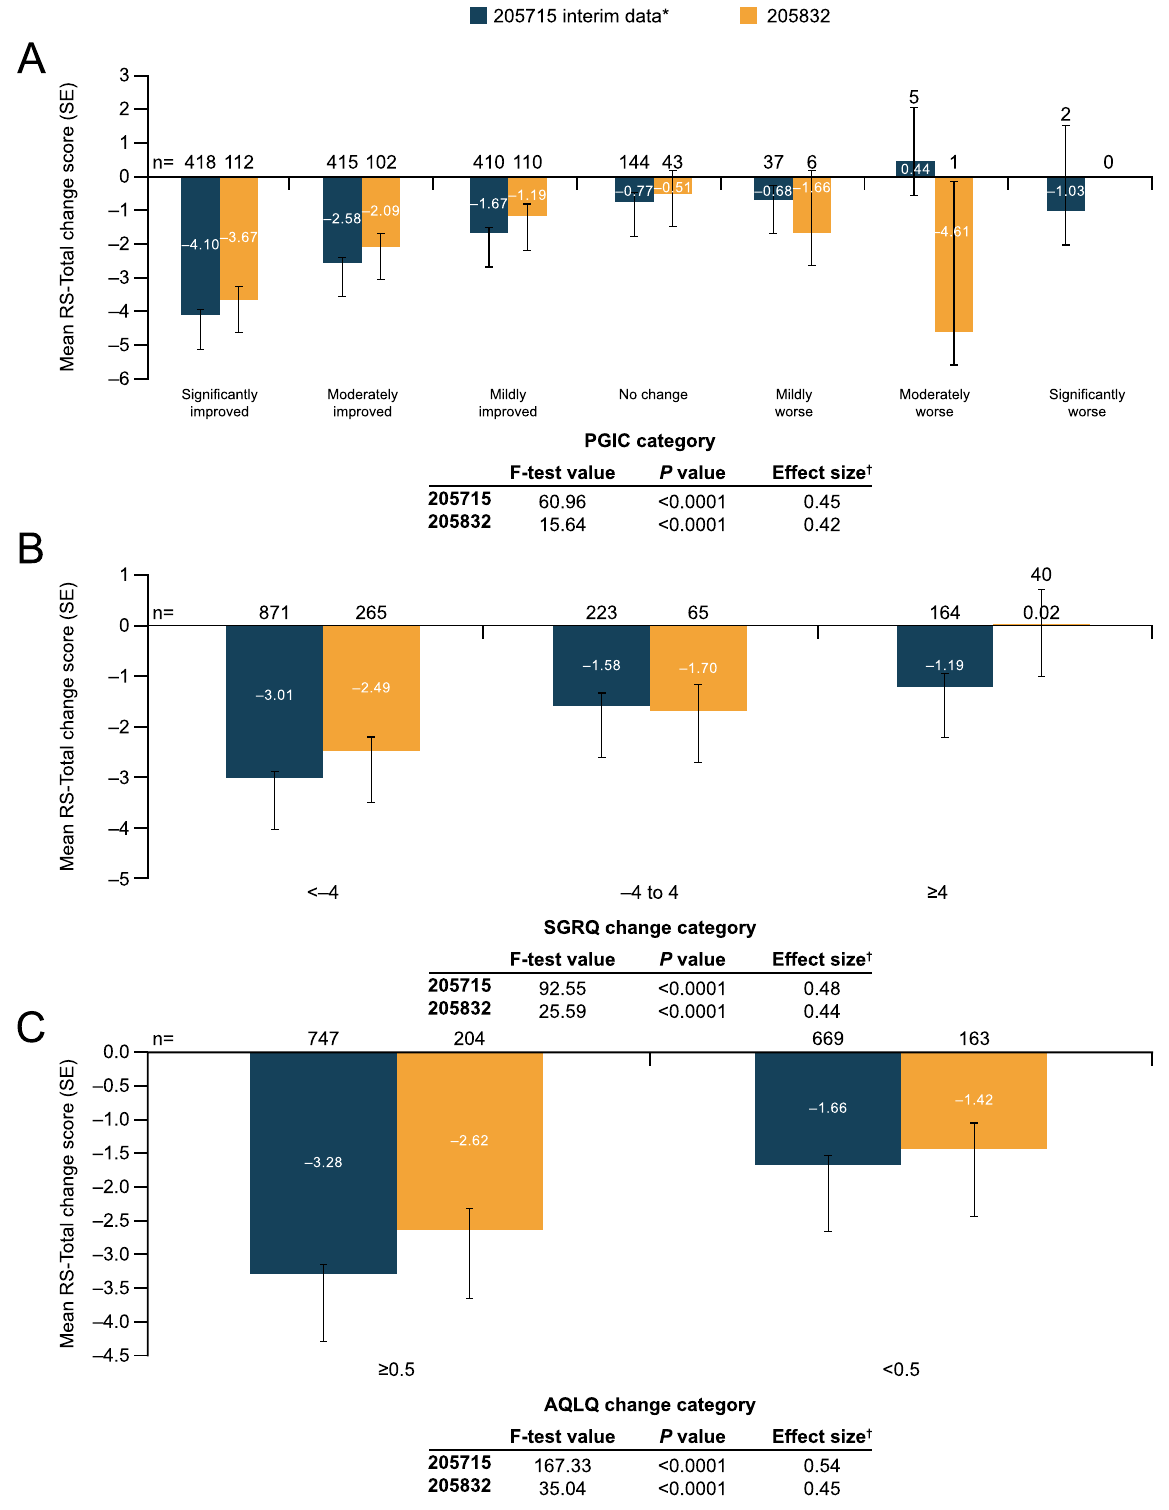
Fig. 3 Responsiveness of weekly RS-Total scores using A PGIC, B SGRQ, and C AQLQ. Note: ANCOVA of E-RS change scores from baseline (Week 0) to Week 24 in 205715 and 205832 studies. *Interim blinded data only; † Among patients defined as “ responders ” (PGIC improvement, SGRQ change < − 4, or AQLQ change ≥ 0.5). AQLQ, Asthma Quality of Life Questionnaire; PGIC, Patient Global Impression of Change; SE, standard error; SGRQ, St George ’ s Respiratory